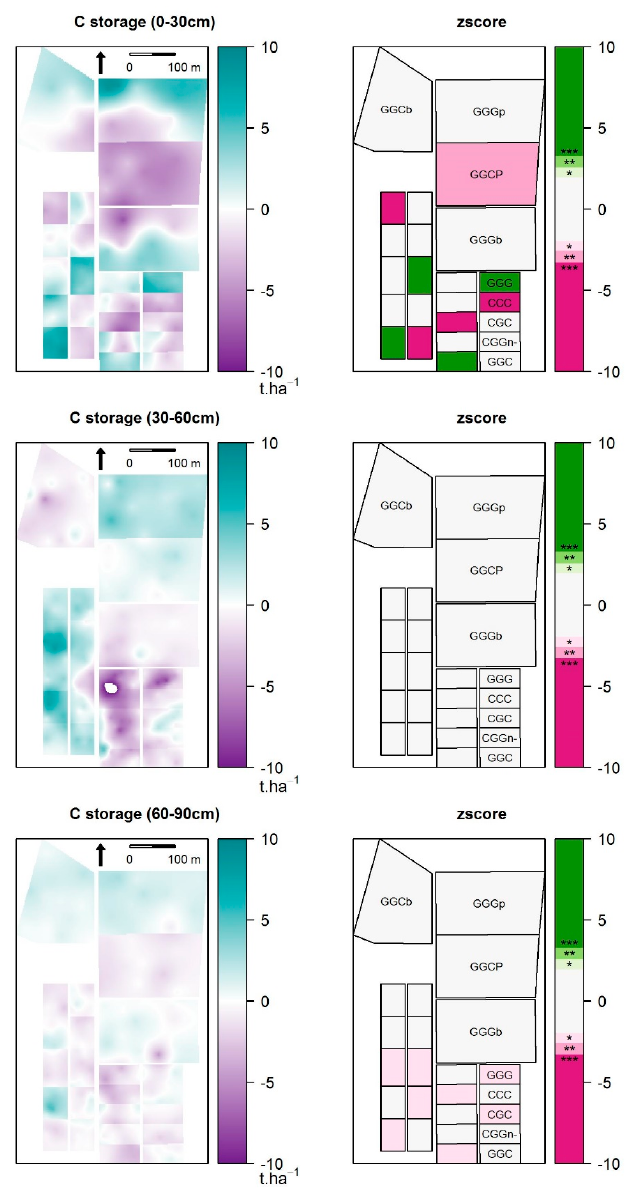
Figure 3. Soil organic carbon (SOC) storage change calculated by different co-kriging-predicted C 2005 stock and C 2014 stock in for 0–30, 30–60 and 60–90 cm depths. Z-score calculated for each treatment (for Z-score > 1.96 or < − 1.96, the p -value is 0.05 *, for Z-score > 2.58 or < − 2.58, the p -value is 0.01 ** and for Z-score > 3.29 or < − 3.29, the p -value is 0.001 ***)